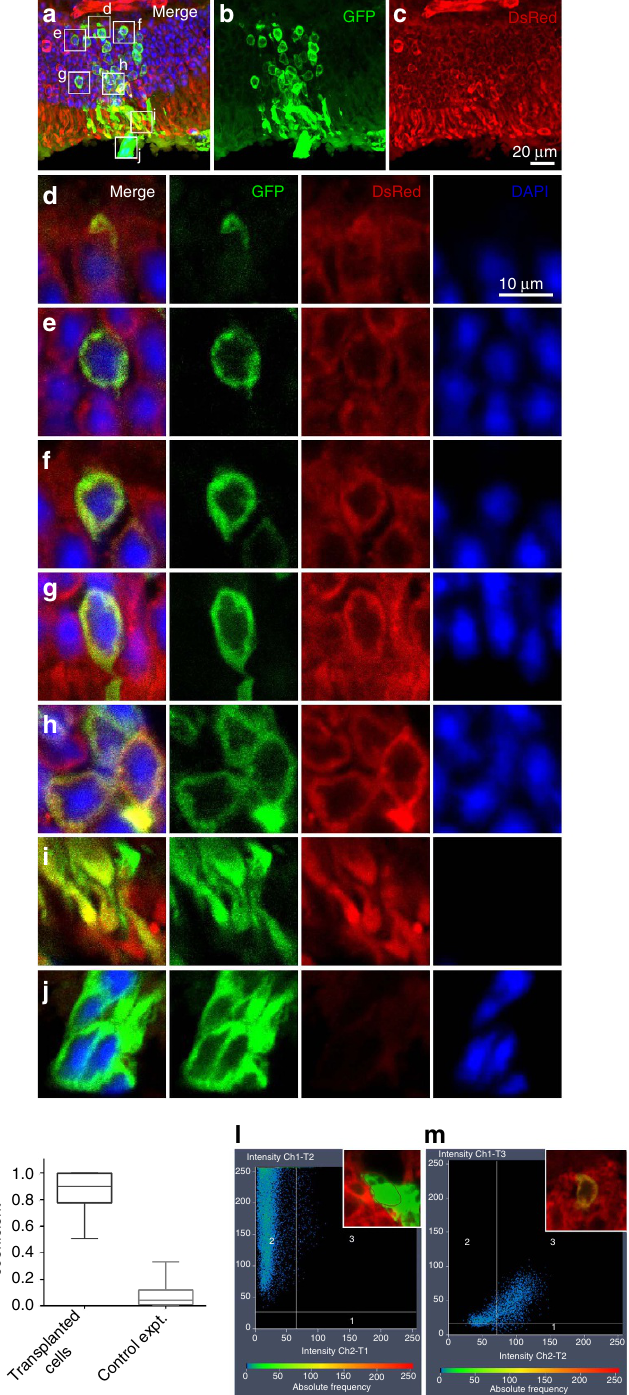
Figure 1 | The majority of putative donor cells (GFP positive) in the host outer nuclear layer also contain a fluorescent marker that is present in the host (DsRed). Postnatal day 1–3 (P1–3) Nrl-GFP donor photoreceptor precursors were transplanted into the subretinal space of adult CAG-DsRed